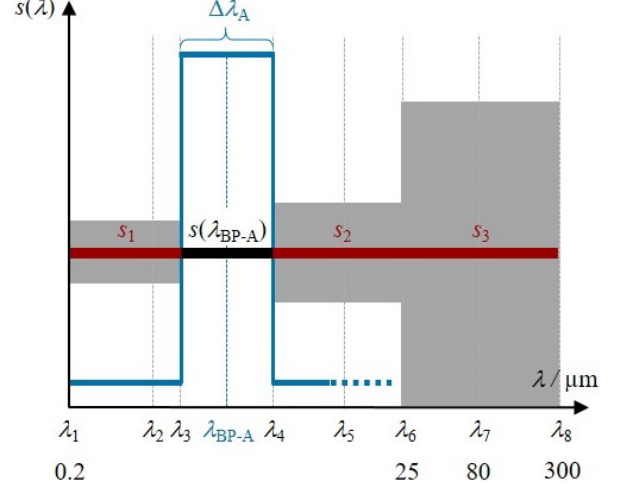
Figure 4. Model for the spectral responsivity in the out-of-bandpass range (red) including the uncertainty of this assumption (grey) in line with the transmittance of the bandpass filter A (blue).